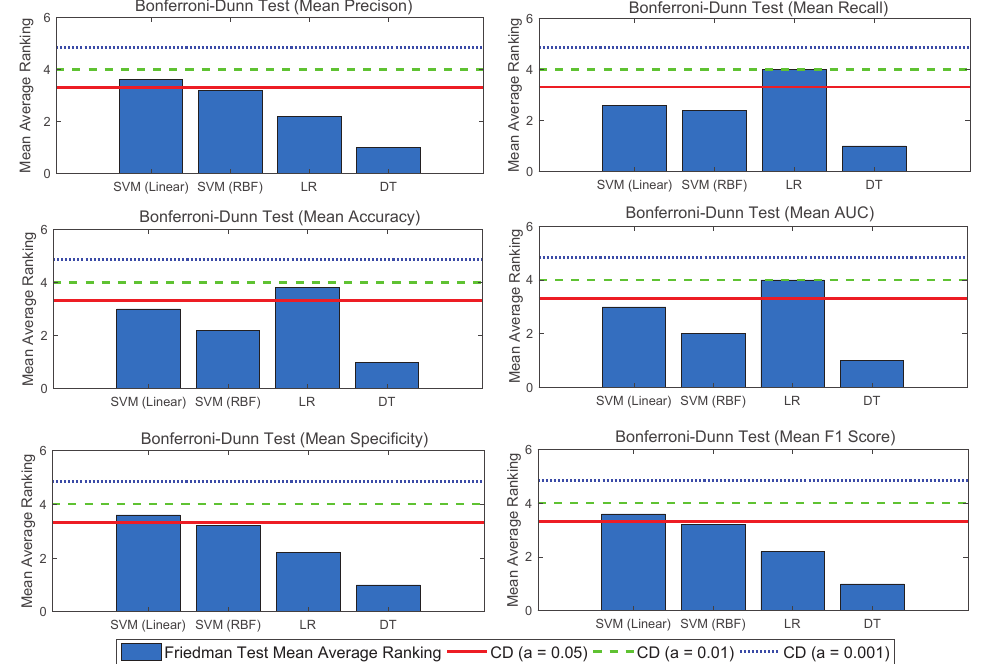
Figure 7. Result ranked with Friedman test and Bonferroni–Dunn test of four ML algorithms (SVM (Linear kernel), SVM (RBF kernel), LR, and DT ) with precision, recall, accuracy, AUC, Specificity, and F1 Score in significant levels of α < 0.05, α < 0.01, and α < 0.001 taking DT as a control algorithm in Figure 5